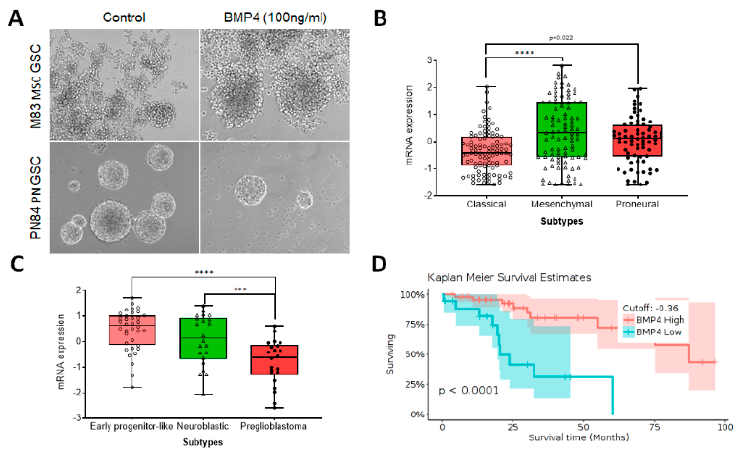
Figure 2. BMP4 expression in adult glioblastoma subtypes, associated with patient outcome. ( A ) Representative images show that mesenchymal stem cell (MSC) subtype M83 glioma stem-like cells (GSCs) and proneural (PN) PN84 GSCs respond differentially to BMP4 treatment for 96 h, with only PN84 GSCs showing decreased proliferation. ( B – D ) In silico TCGA data analysis with